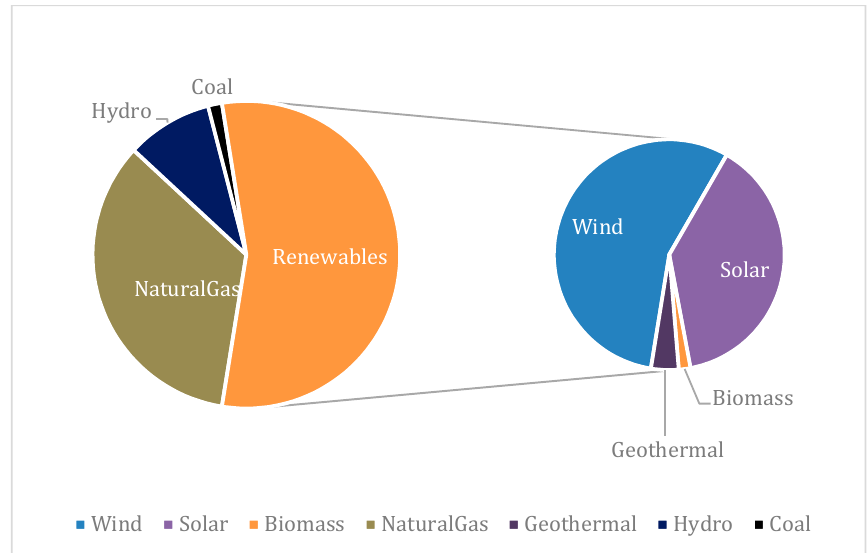
Figure 4. SWITCH Results for 2030 in California—Mid Demand Scenario—Power Capacity.